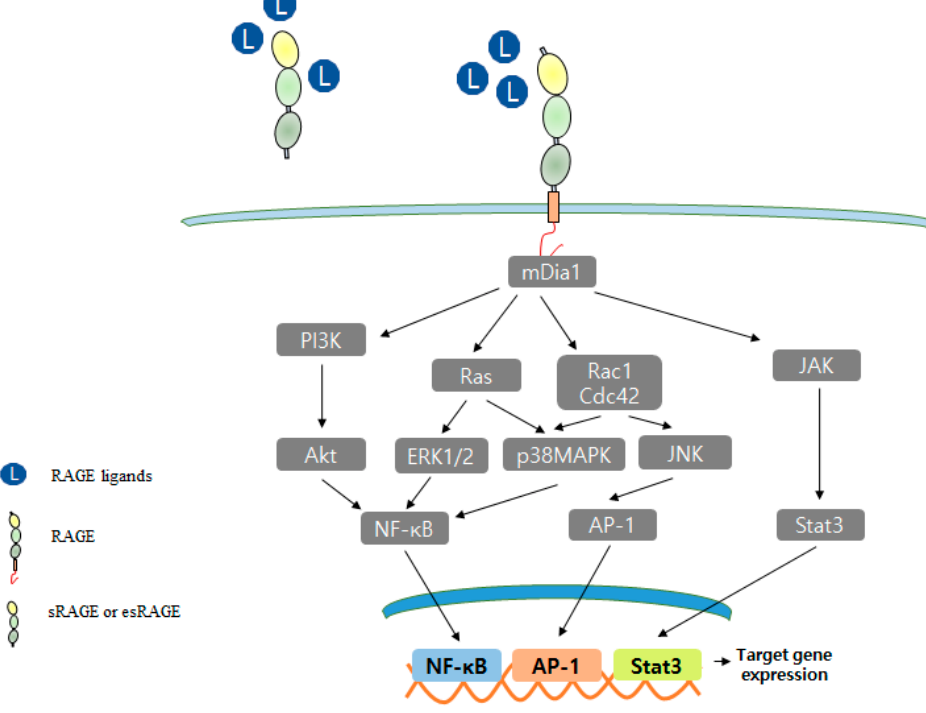
Figure 2. RAGE signal transduction pathway. RAGE interacts with a diverse spectrum of extracellular ligands and multi- ple signal transduction pathways, including PI3K, p28MAPK, Rho GTPase, Rac1, and JAK pathways. At the transcrip- tional level, NF- κ B, AP-1, and Stat3 have upregulated as vital targets of RAGE signaling, nevertheless other transcription